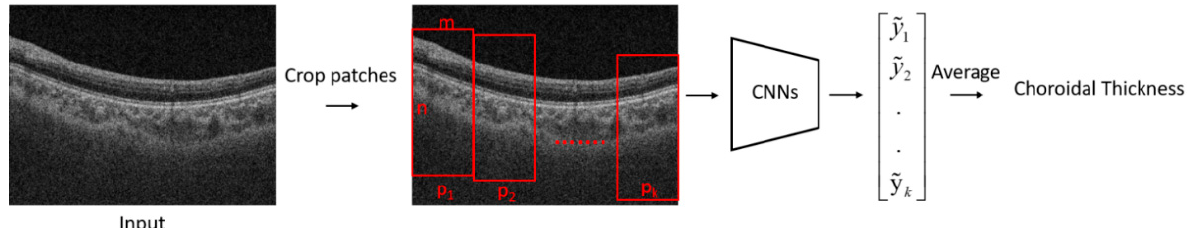
Figure 1. The flowchart of the proposed method for estimation of choroidal thickness. A B-scan image was first cropped into several patches. A trained CNN model was then used to estimate the choroidal thickness for each patch. The mean thickness of the choroid in the B-scan was obtained by taking the average of the choroidal thickness on each patch. m and n are the width and height of a patch p respectively.